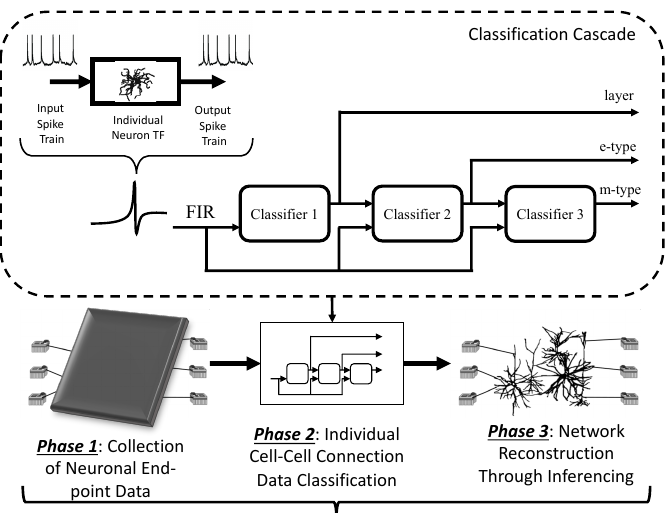
Figure 1. Overview of the objective multi-variable classification and inference of biological neuronal networks. First, in Phase 1, we collect end-point neuronal voltage data and this is performed through simulations of cortical neuron networks. We derive finite impulse responses (FIR) models from individual neuron transfer functions (TF) which are used in our mutual information and spike delay estimation analysis. Then, in Phases 2 and 3, we propose a cascade of supervised classification algorithms using features from our information and communication analysis based on various forms of cortical networks, from generic networks motifs to existing ones found in biology. Finally, we reconstructed the cell-types in a known topology based on end-point measurements taken around the